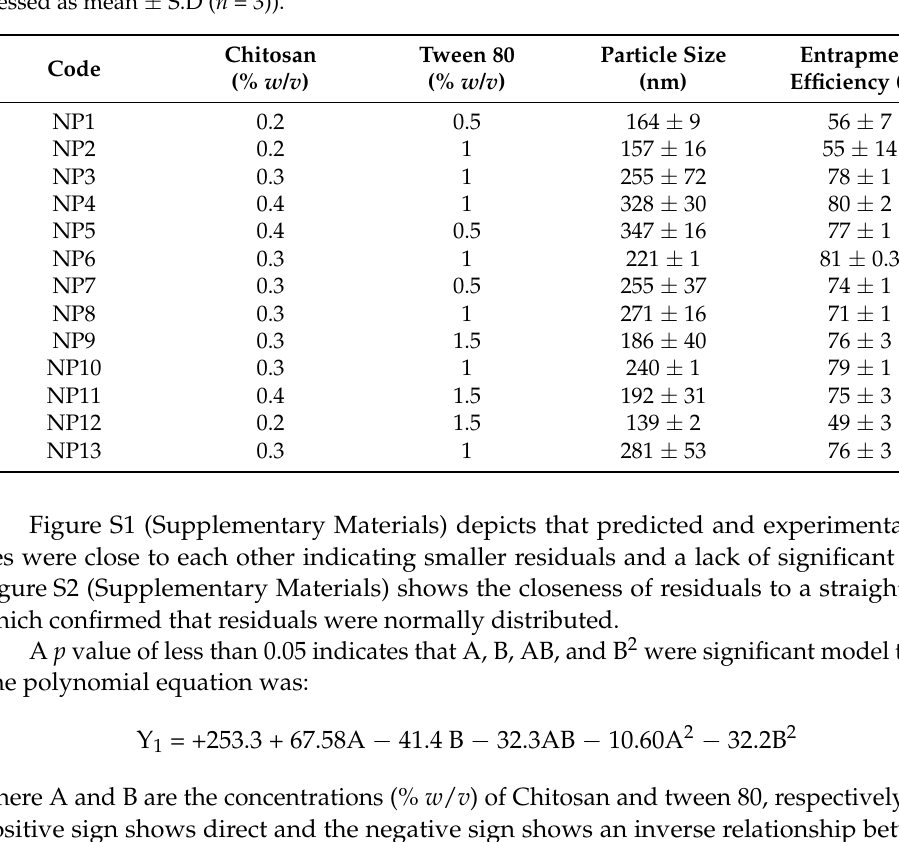
Table 1. Different runs of TBN-CSNP formulations suggested by FCCCD and their responses (Ex- pressed as mean ± S.D ( n =